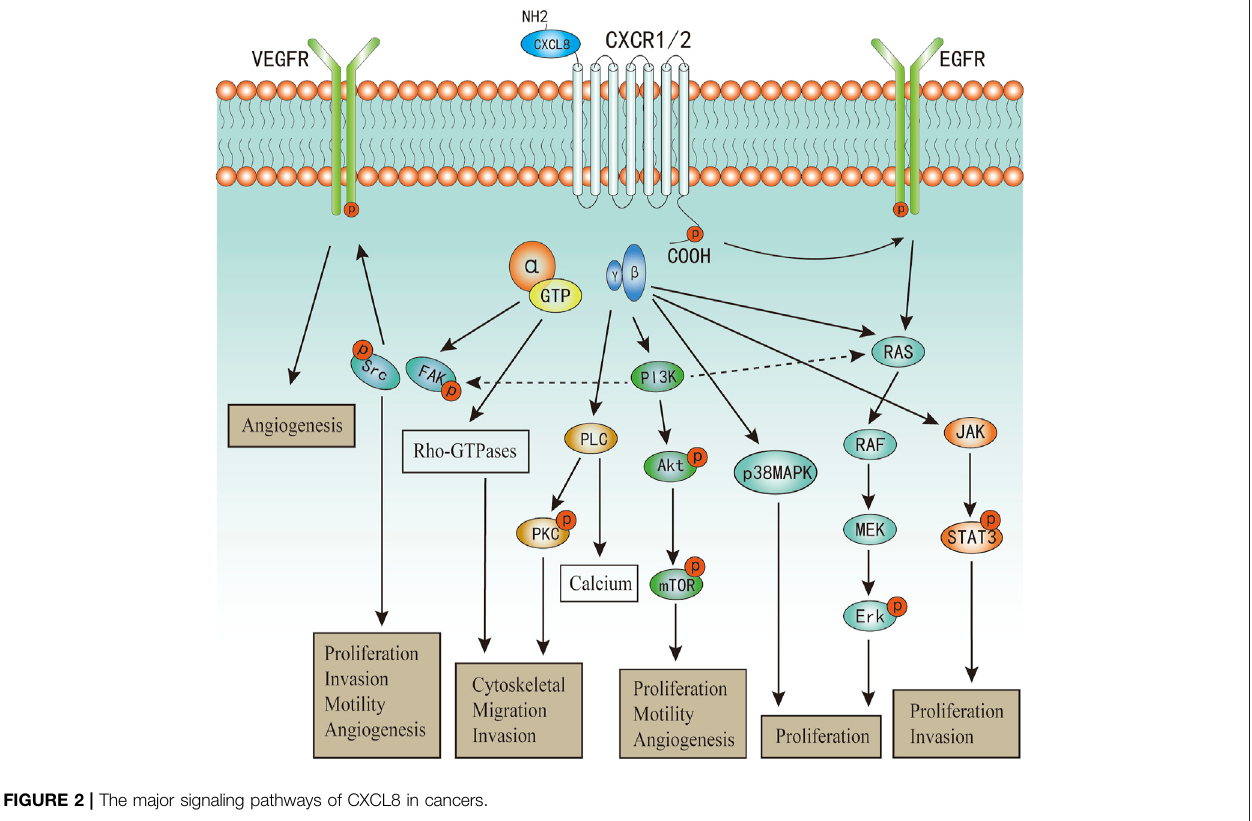
FIGURE 2 | The major signaling pathways of CXCL8 in cancers.